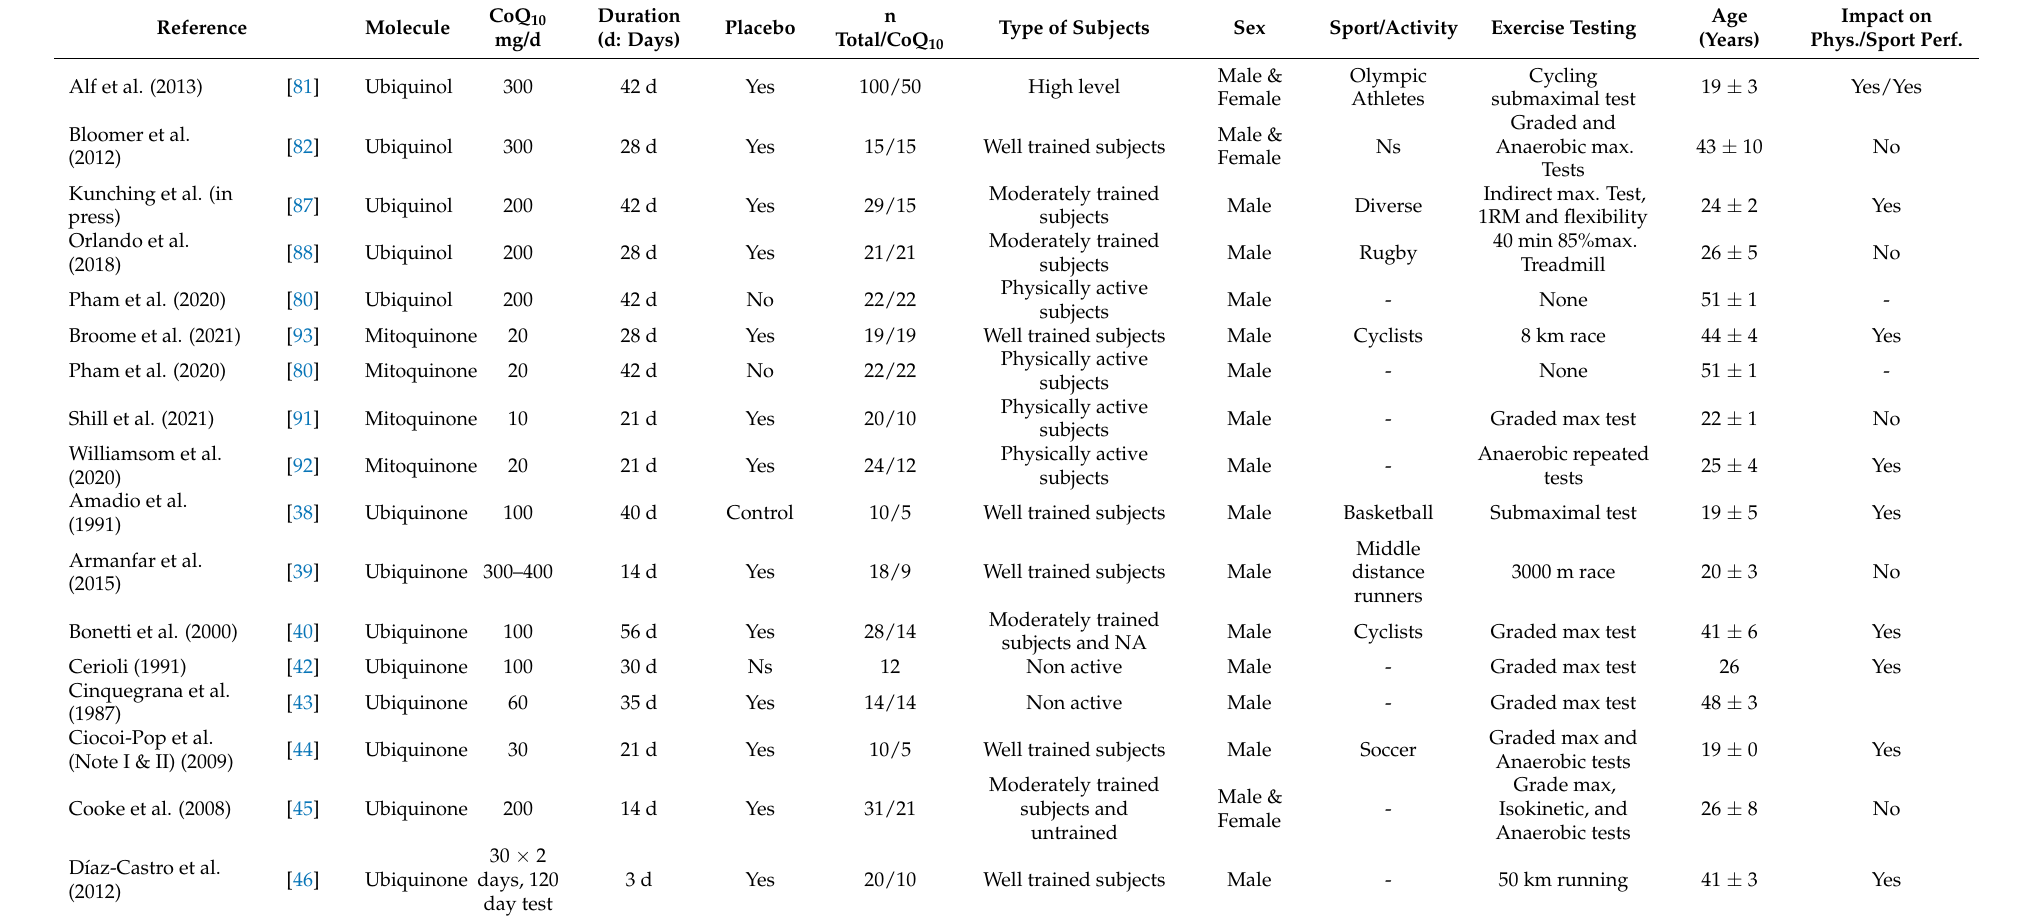
Table 4. Studies without the inclusion